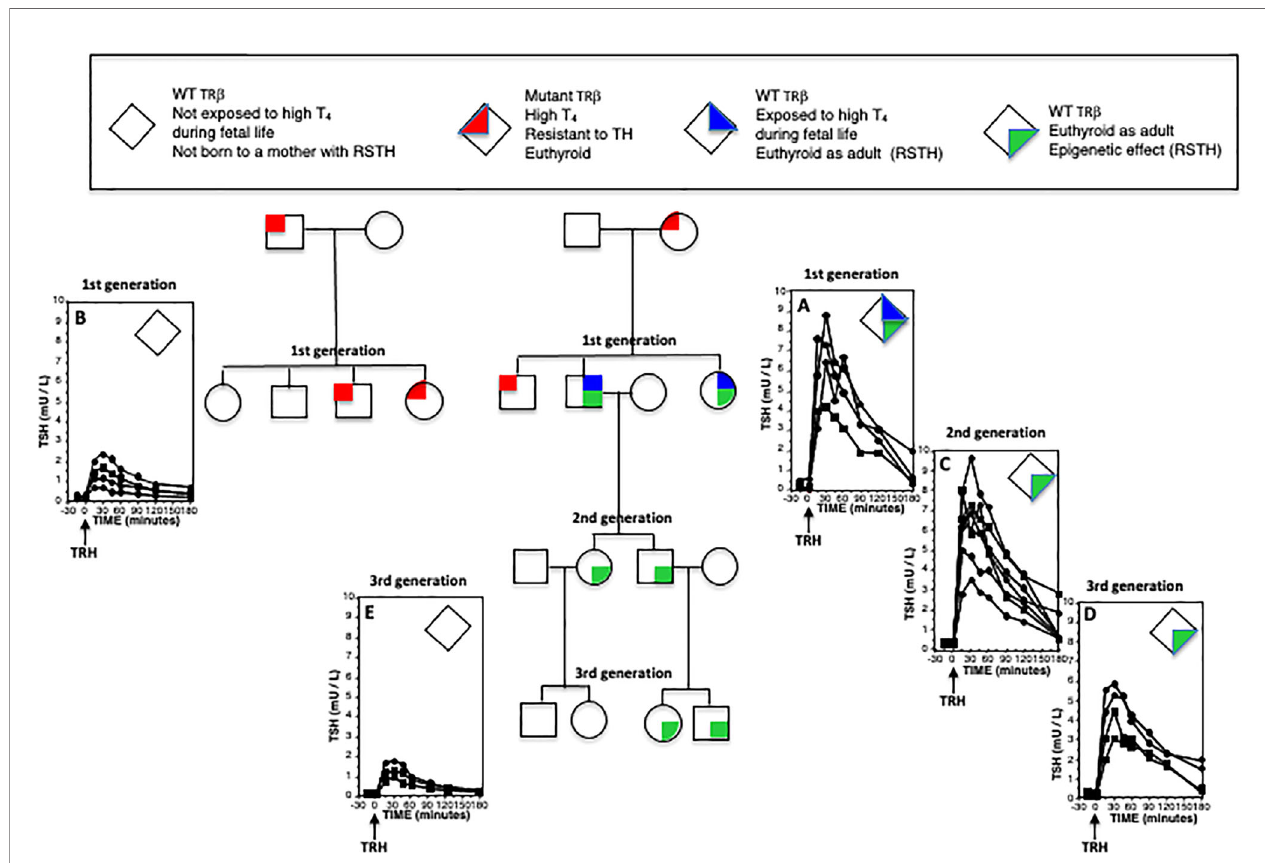
FIGURE 2 | Epigenetic effect of RTH b and its transgenerational inheritance across the male line. Individuals were given 25 µg L-T 3 twice daily for three days. They were then injected intravenously with 200 µg of thyrotropin releasing hormone (TRH) and samples of blood were obtained at the indicated times for the measurement of serum TSH. Plotted on the graphs are results from female (circles) and males (squares). Increased peak responses in (A, C, D) , as compared to those of (B, E) indicate reduced sensitivity to thyroid hormone (RSTH). While this epigenetic effect of exposure to high TH levels during fetal life (A) is transmitted to both sexes, it is inherited along male line only (C, D) but not the female line (E)